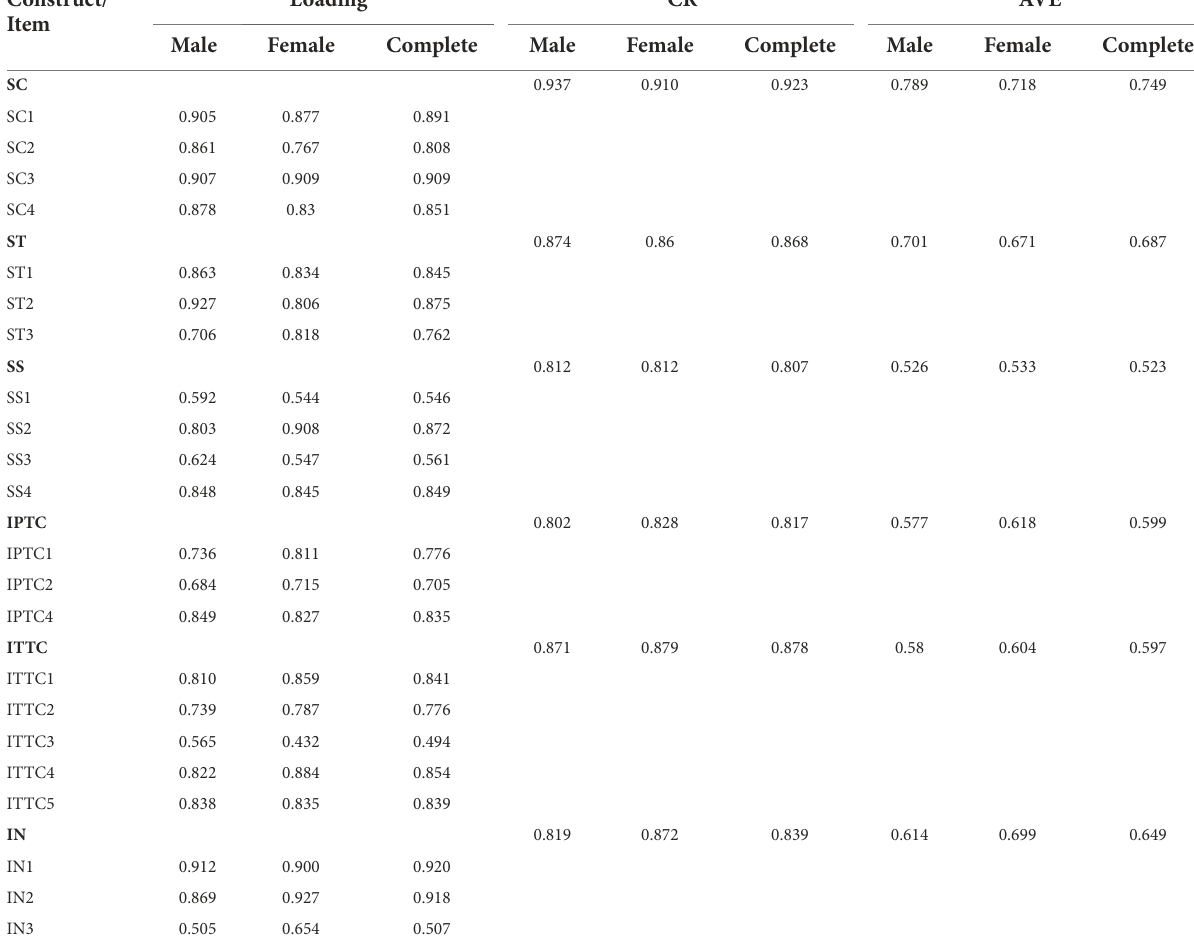
TABLE 2 Internal consistency and convergent validity.